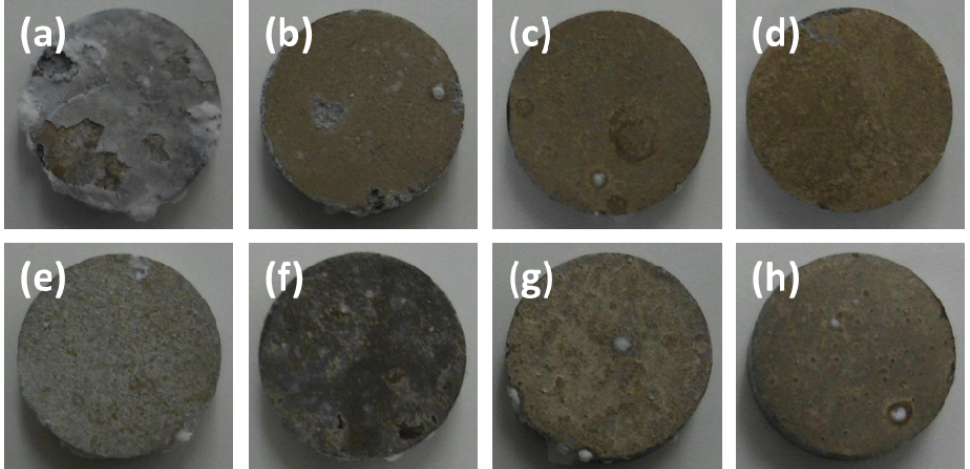
Figure 1. Optical images of corroded surface after immersion test for 10 days in modified Gamble’s solutions: ( a ) Solution #1; ( b ) Solution #2; ( c ) Solution #3; ( d ) Solution #4; ( e ) Solution #5; ( f ) Solution #6; ( g ) Solution #7; ( h ) Solution